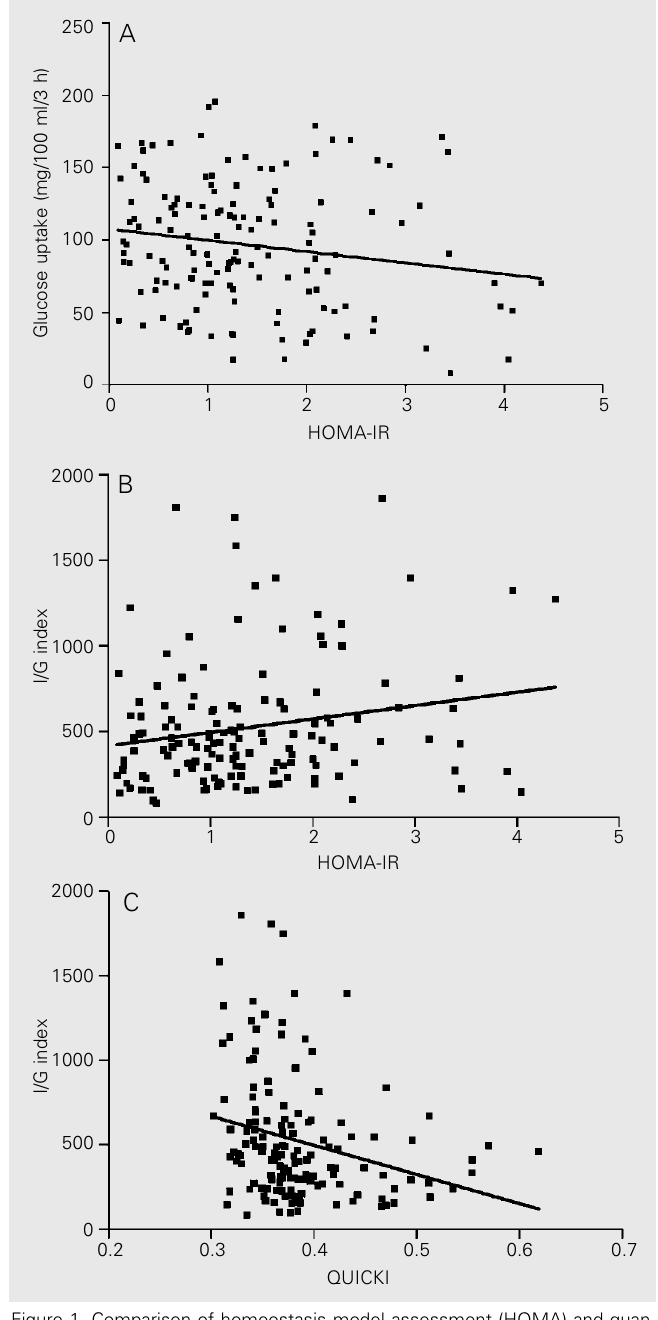
Figure 1. Comparison of homeostasis model assessment (HOMA) and quan- titative insulin sensitivity check index (QUICKI) with data from forearm meta- bolic studies for the assessment of in vivo insulin sensitivity. A , Glucose uptake vs HOMA-IR. Data are for 167 patients and healthy individuals (r = -0.16, P = 0.04; Spearman correlation test). B , Insulin/glucose (I/G) index vs HOMA-IR. Data are for 167 patients and healthy individuals (r = 0.17, P = 0.03; Spearman correlation test). C , I/G index vs QUICKI. Data are for 167 patients and healthy individuals (r = -0.37, P < 0.0001; Spearman correlation test). IR = insulin